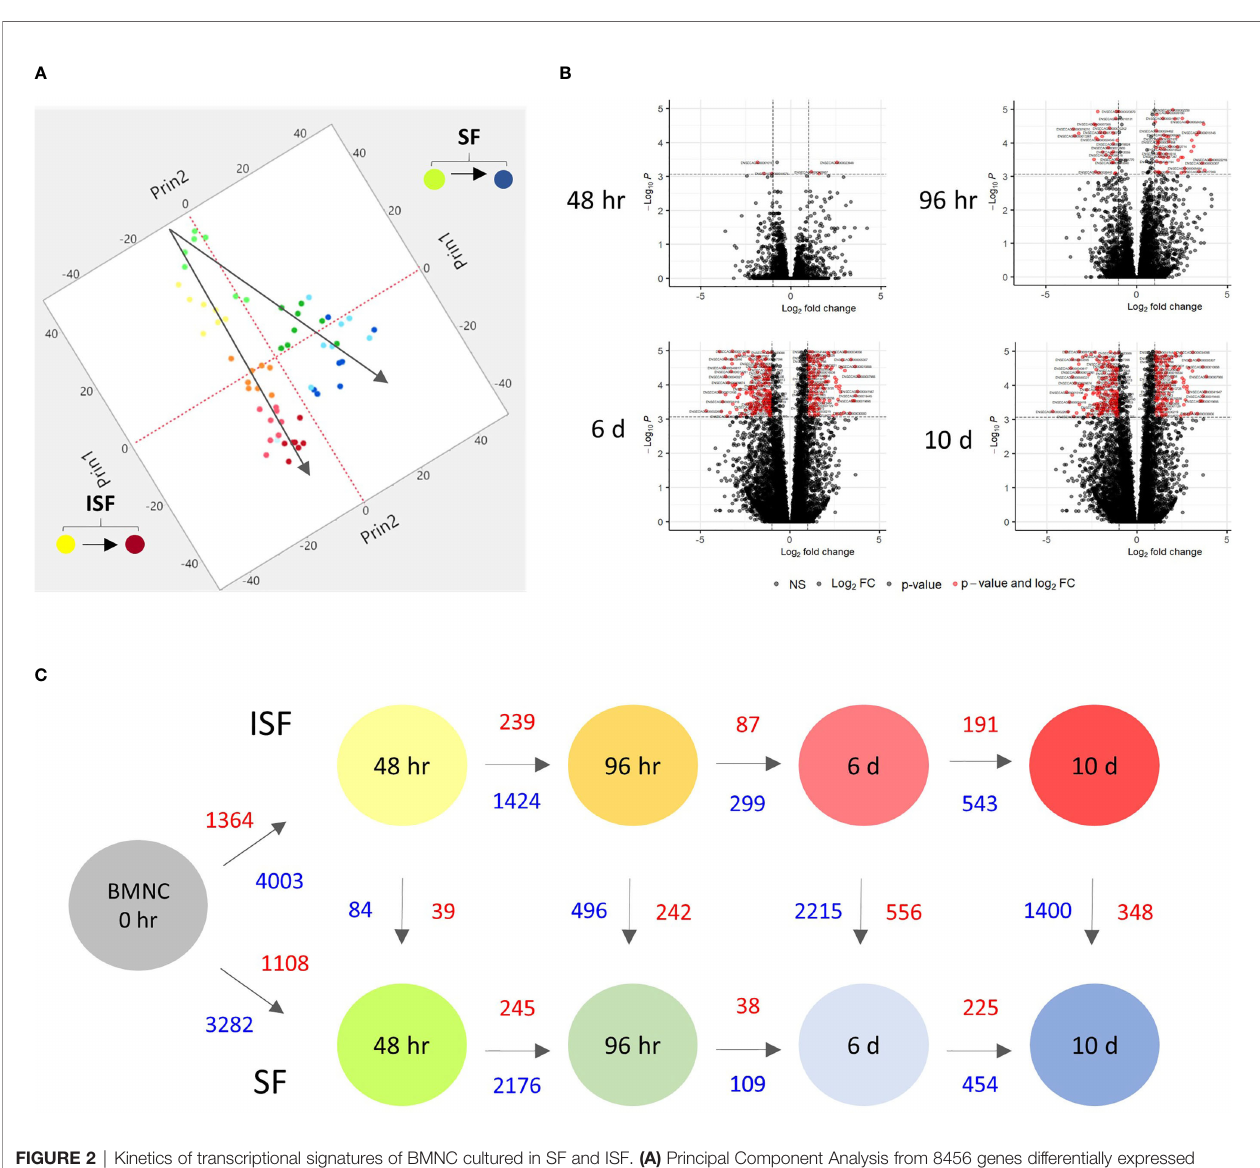
FIGURE 2 | Kinetics of transcriptional signatures of BMNC cultured in SF and ISF. (A) Principal Component Analysis from 8456 genes differentially expressed (DEGs) by BMNC following culture in SF (green to blue dots; top) and ISF (yellow to red dots; bottom) for 10 days shows increasing divergence in the patterns of gene expression over time. Each dot color represents a different time point and each dot represents an individual horse. (B) Volcano plots depicting downregulated (left red quadrant) and upregulated (right red quadrant) DEGs in ISF compared to SF cultures at each time point, showing major changes at 6 days. (C) Schematic of changes in gene expression of BMNC cultured in SF (bottom) and ISF (top) for 10 days, depicting the number of DEGs over consecutive time points within groups (horizontal comparisons in SF or ISF) and between groups (vertical comparisons) at each time point (FDR ≤ 0.05). Numbers represent upregulated (red text) and downregulated genes (blue text) between the compared